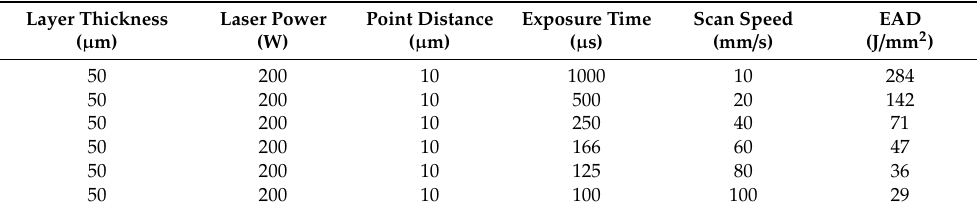
Table 2. Working parameters of the SLM process.